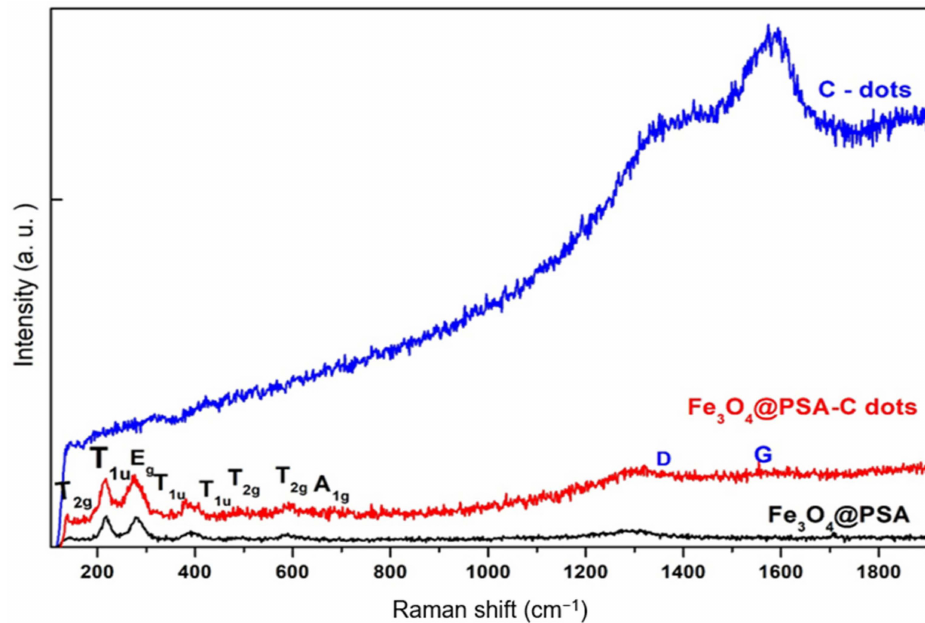
Figure 4. Raman spectra of C-dots; Fe 3 O 4 @PSA-Cdots and Fe 3 O 4 @PSA nanoparticles.